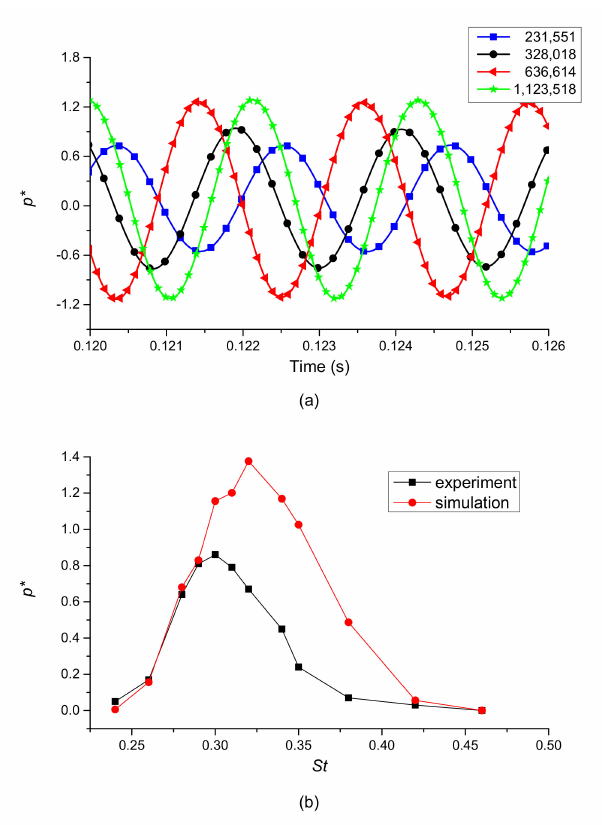
Figure 5. Verification for grid-independent solutions ( a ); validation between the experimental data of Ziada et al. [27] and the current simulation results ( b